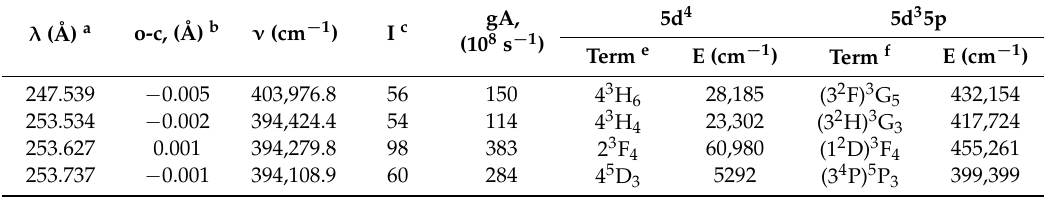
Table A2. Identified lines of the 4d 4 –4d 3 5p transitions in the spectrum of Ag 7+